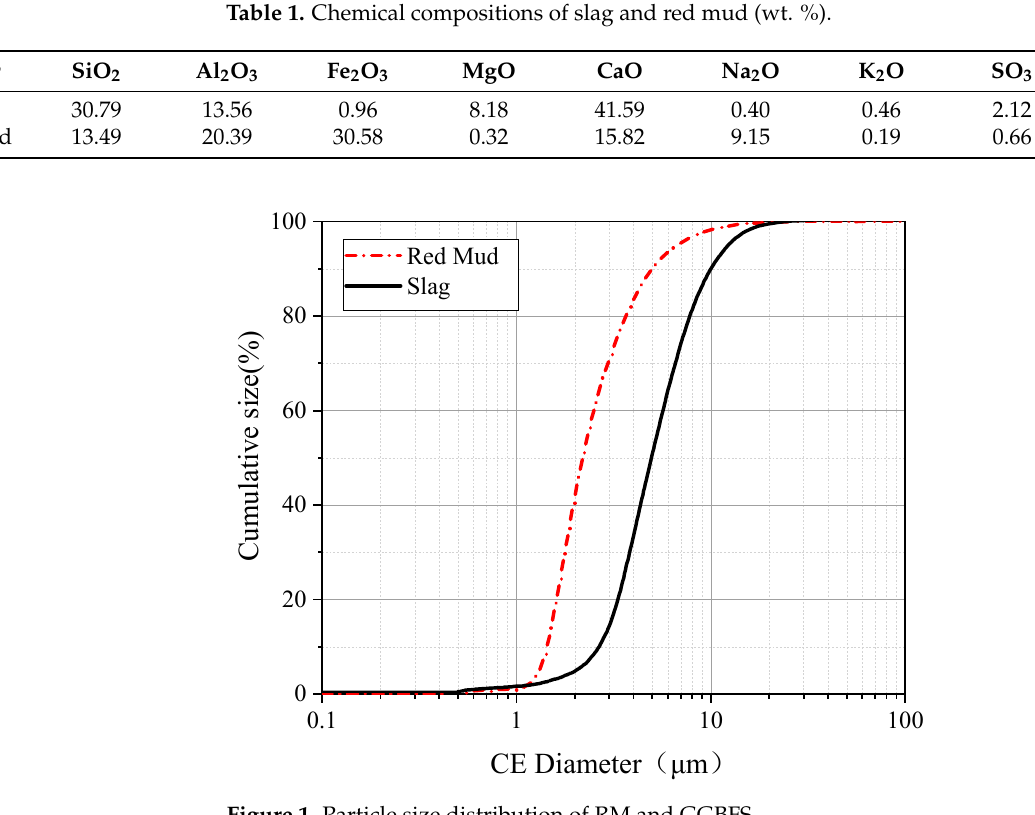
Table 1. Chemical compositions of slag and red mud (wt. %).